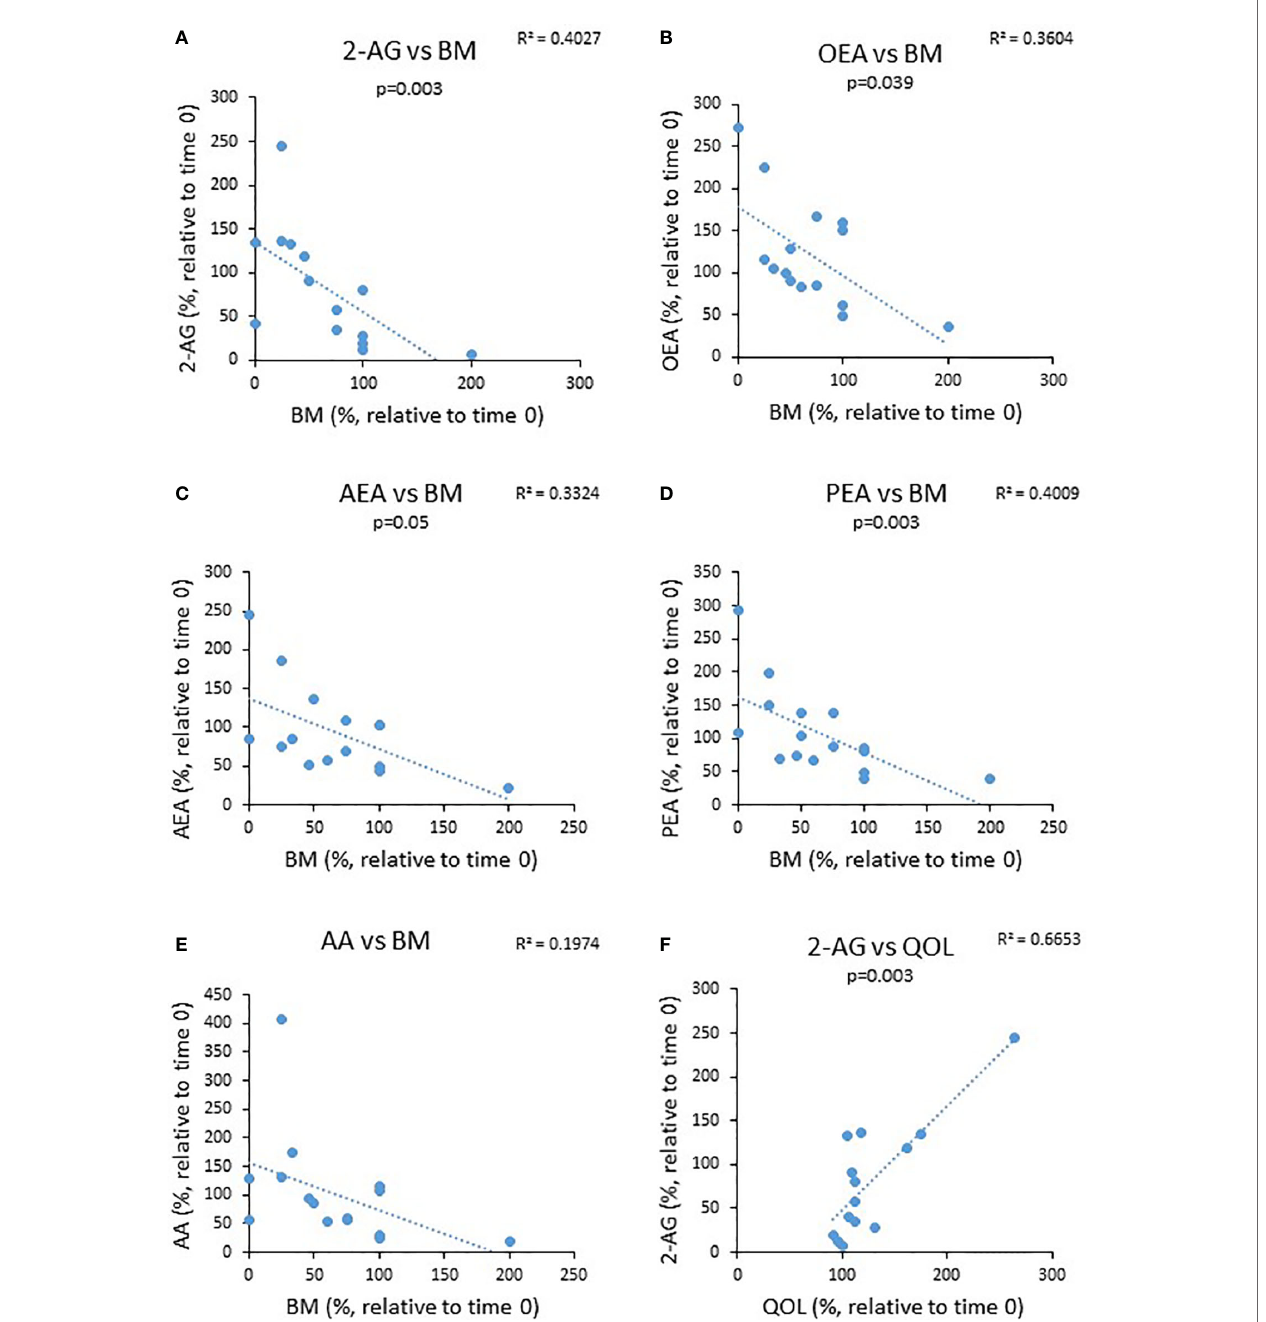
FIGURE 5 | The relationship between changes in eCBs level during the trial to changes in clinical parameters. UC patients were treated for 8 weeks with cannabis or placebo. eCBs level, BM, QOL and Mayo score were evaluated before the beginning of the experiment and 8 weeks later. The graphs describe the changes in BM as a function ofthe changes in the different eCBs level (A – E) and (F) the change in QOL as a function of 2-AG